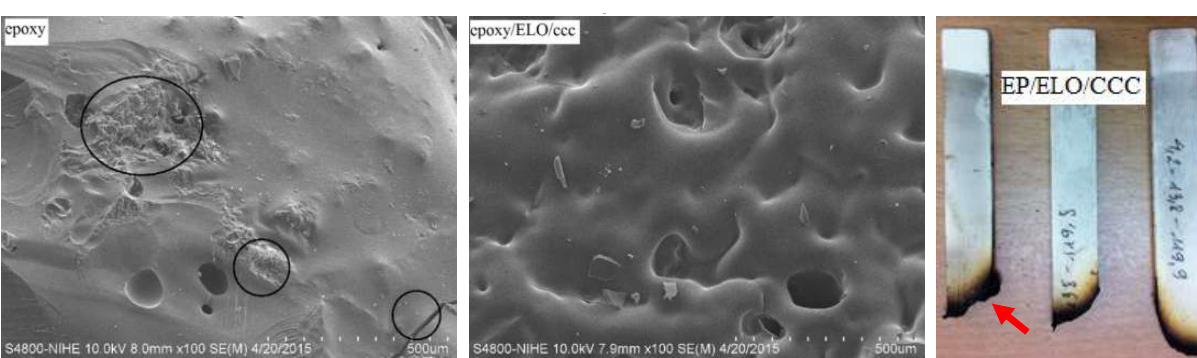
O /CHLORINATED 2 3